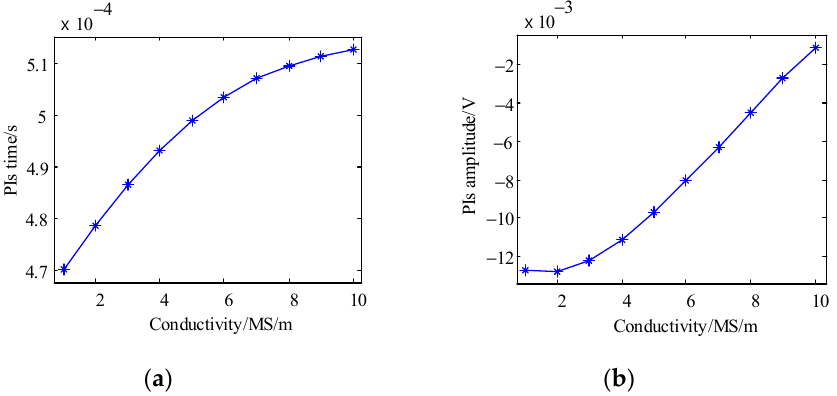
Figure 12. PI time and amplitude curves with thickness. ( a ) PI time curve; ( b ) PI amplitude curve.